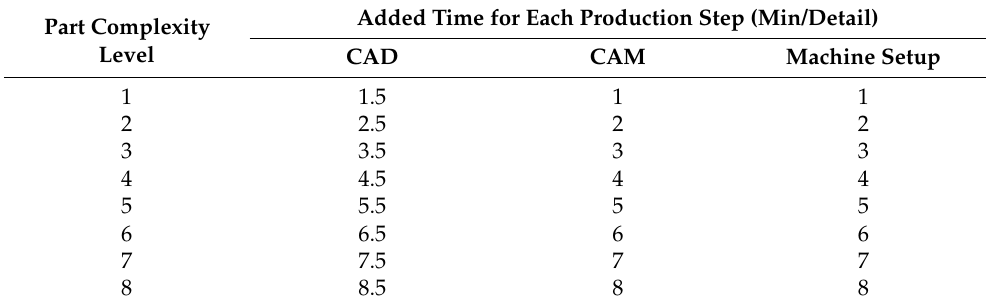
Table 7. Time increment that should be applied to the production steps for each part complexity level. Part Complexity